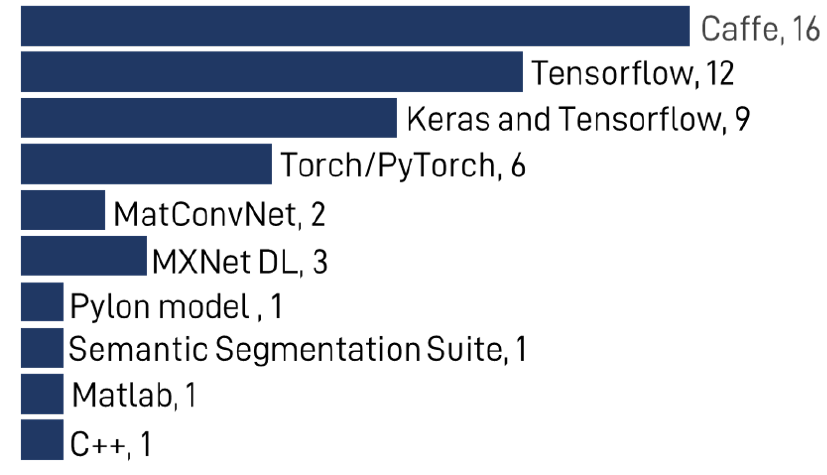
Figure 6. Distribution of frameworks used to wrap the deep learning models.